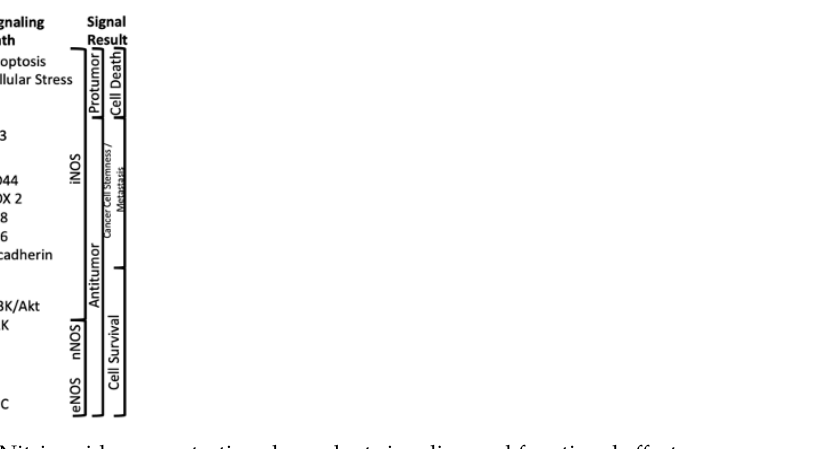
Figure 1. Nitric oxide concentration-dependent signaling and functional effects.